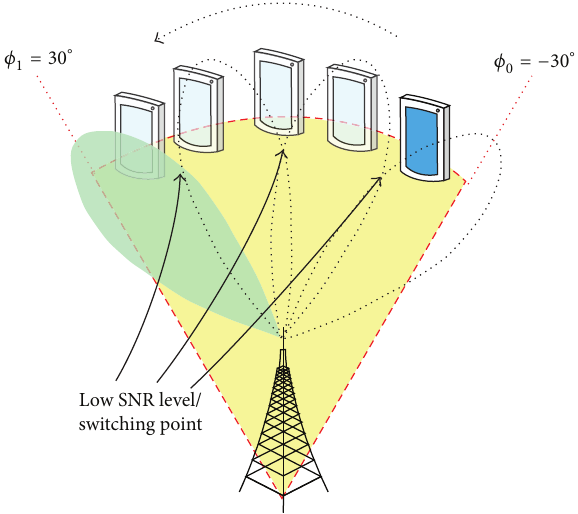
Figure 8: Array with switched beams on a RBS. The switching takes place in the intersection between adjacent beams.